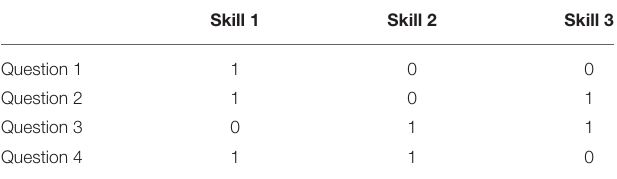
TABLE 1 | A Q-matrix sample. Skill 1 Skill 2 Skill 3